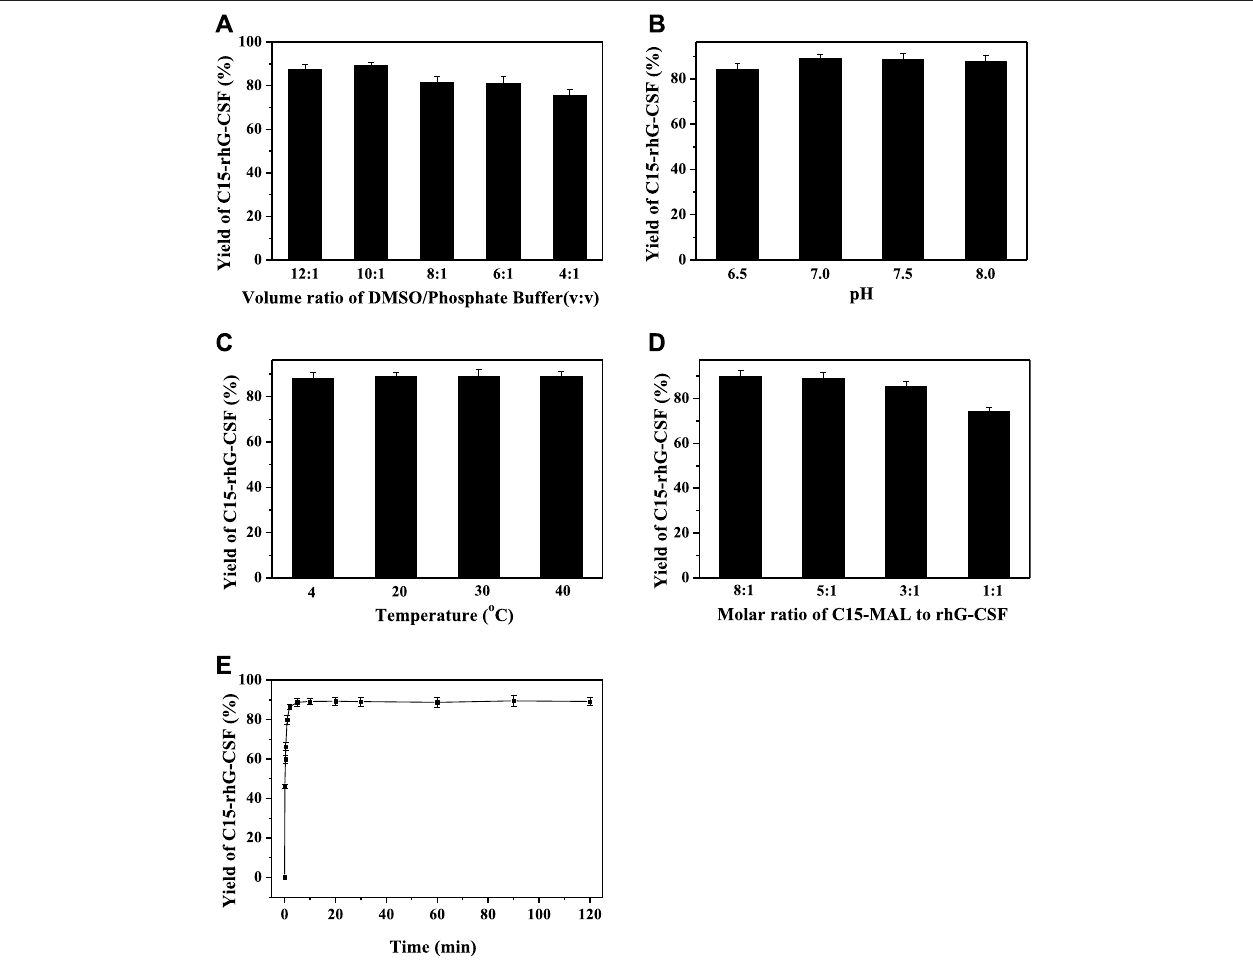
FIGURE 3 | Effects of volume ratio of DMSO/phosphate buffer (A) , pH (B) , temperature (C) , molar ratio of C15-MAL to rhG-CSF (D) and reaction time (E) on the conjugation of rhG-CSF with C15-MAL.